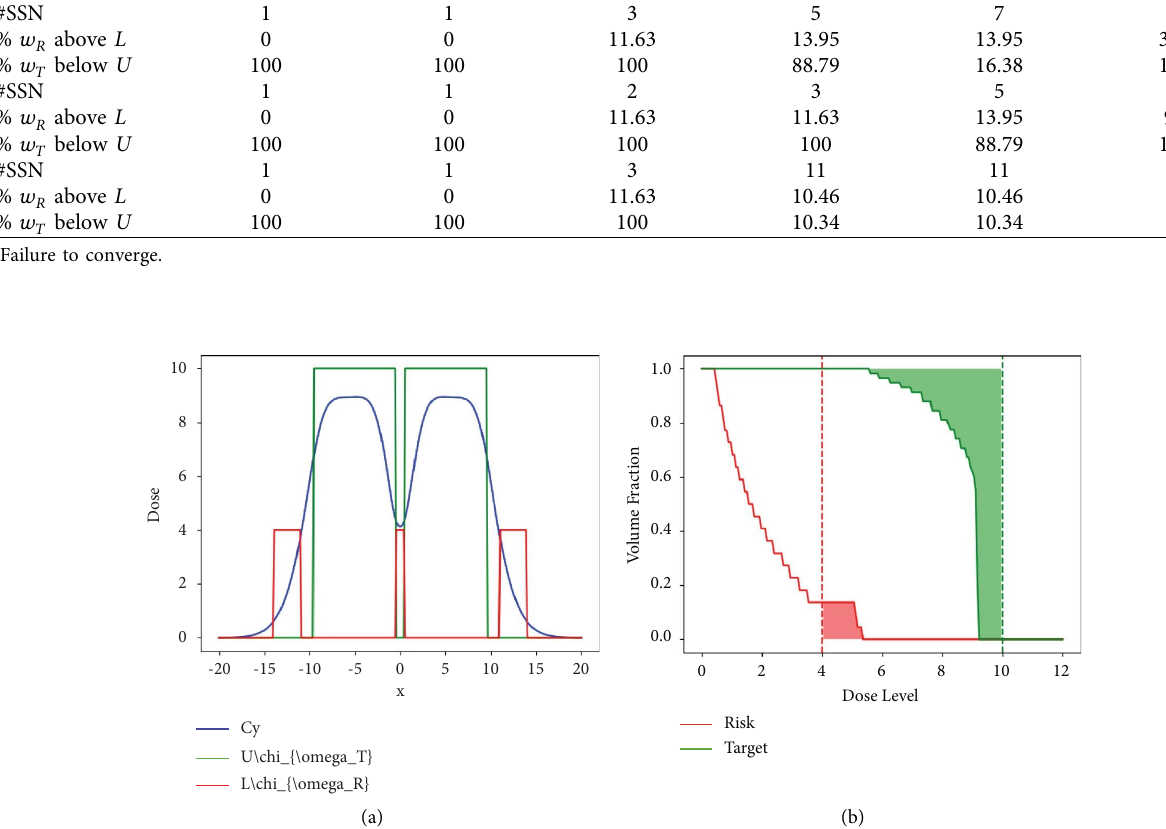
y , risk level L , and target level R . (b) Dose volume w R